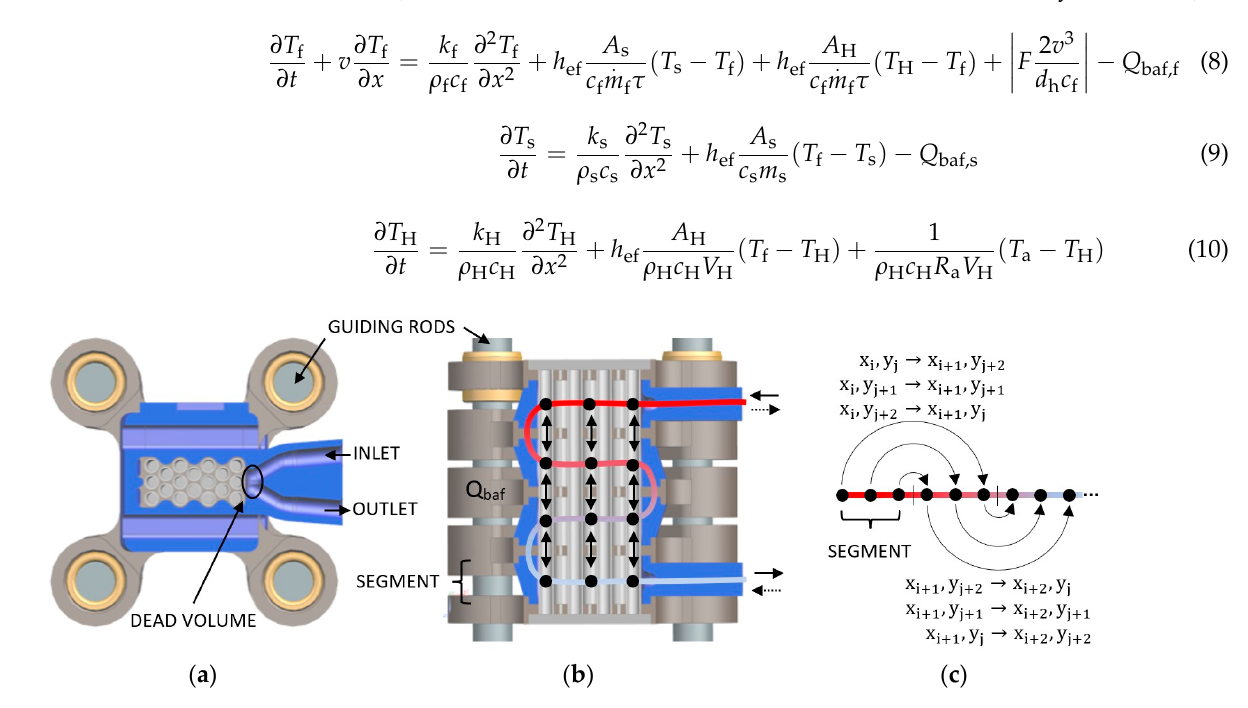
Figure 4. CAD model of the shell-and-tube AeCR: cross-sectional view ( a ); longitudinal view with a schematic representation of the 1D discretization of regenerators’ domain ( b ); and schematic representation of the heat transfer through the baffles in the 1D domain ( c ).